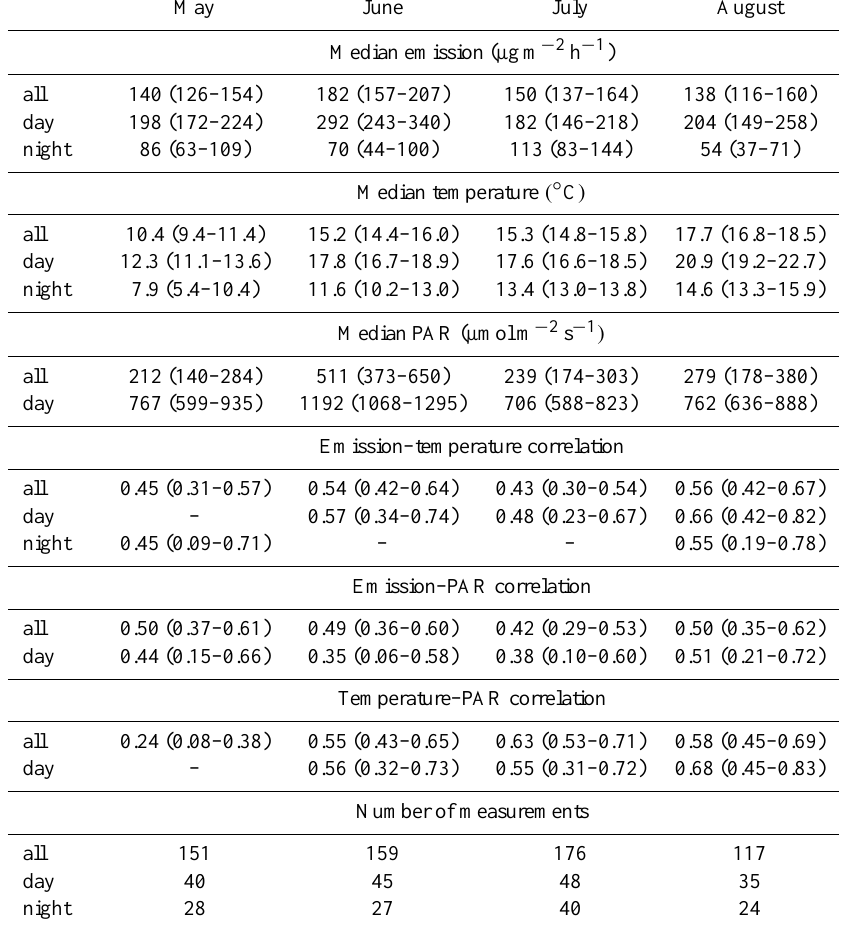
Table 1. Monthly medians and correlations of the monoterpene emissions, air temperature, and photosynthetically active radiation (PAR) during the summer 2007. The values represent all, daytime (12:00–16:00), and night-time (00:00–04:00) measurements. The 95% confidence intervals are in parentheses. Only statistically significant ( p < 0 . 05) correlation coefficients ( r ) are